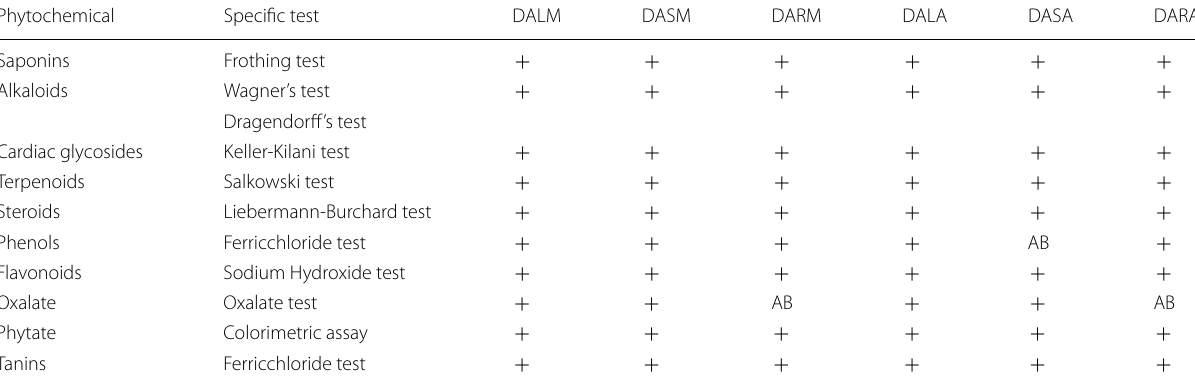
present, AB + = DALM